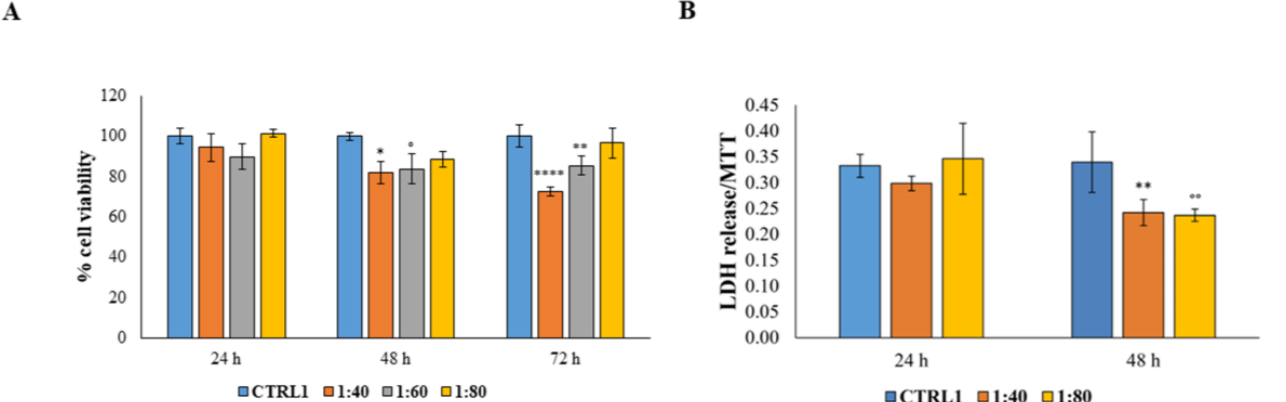
Figure 3. ( A ) MTT assay performed on HGFs treated for 24 h, 48 h, and 72 h with SS diluted at 1:40,